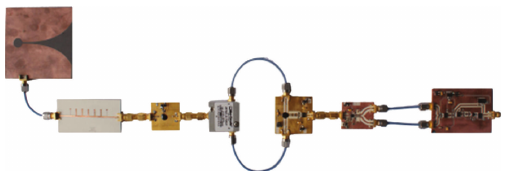
Figure 4: UWB transmit module realized in hardware.